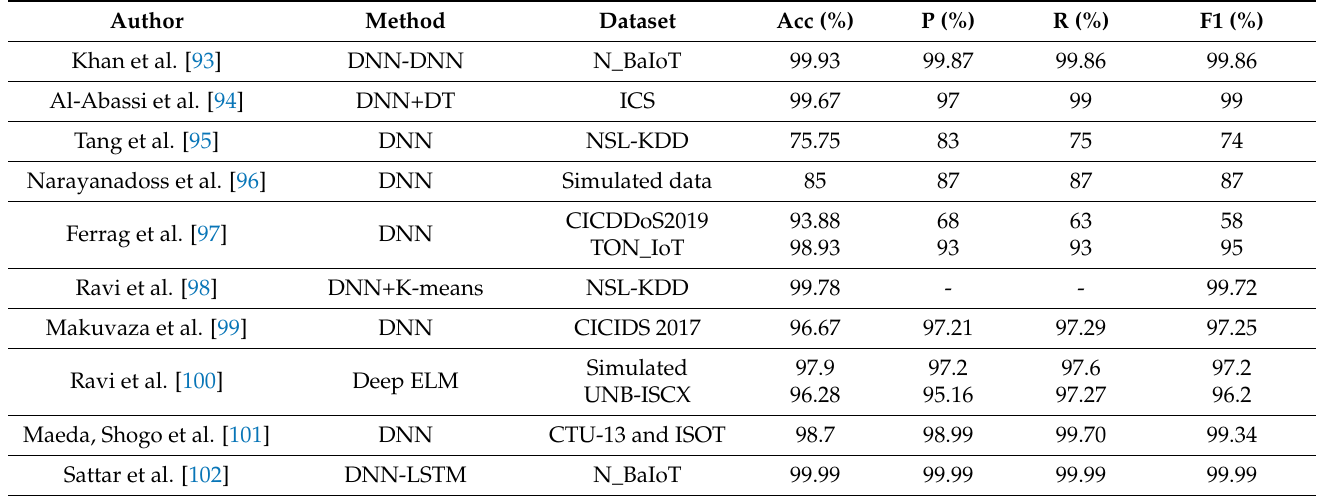
Table 5. Summary of BotNet attack Detection using Deep Neural Network in an SDN-enabled IoT